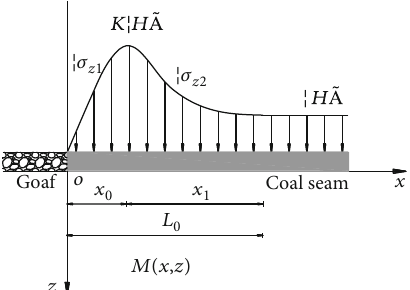
Figure 4: Mechanical model of limit equilibrium in coal pillar.